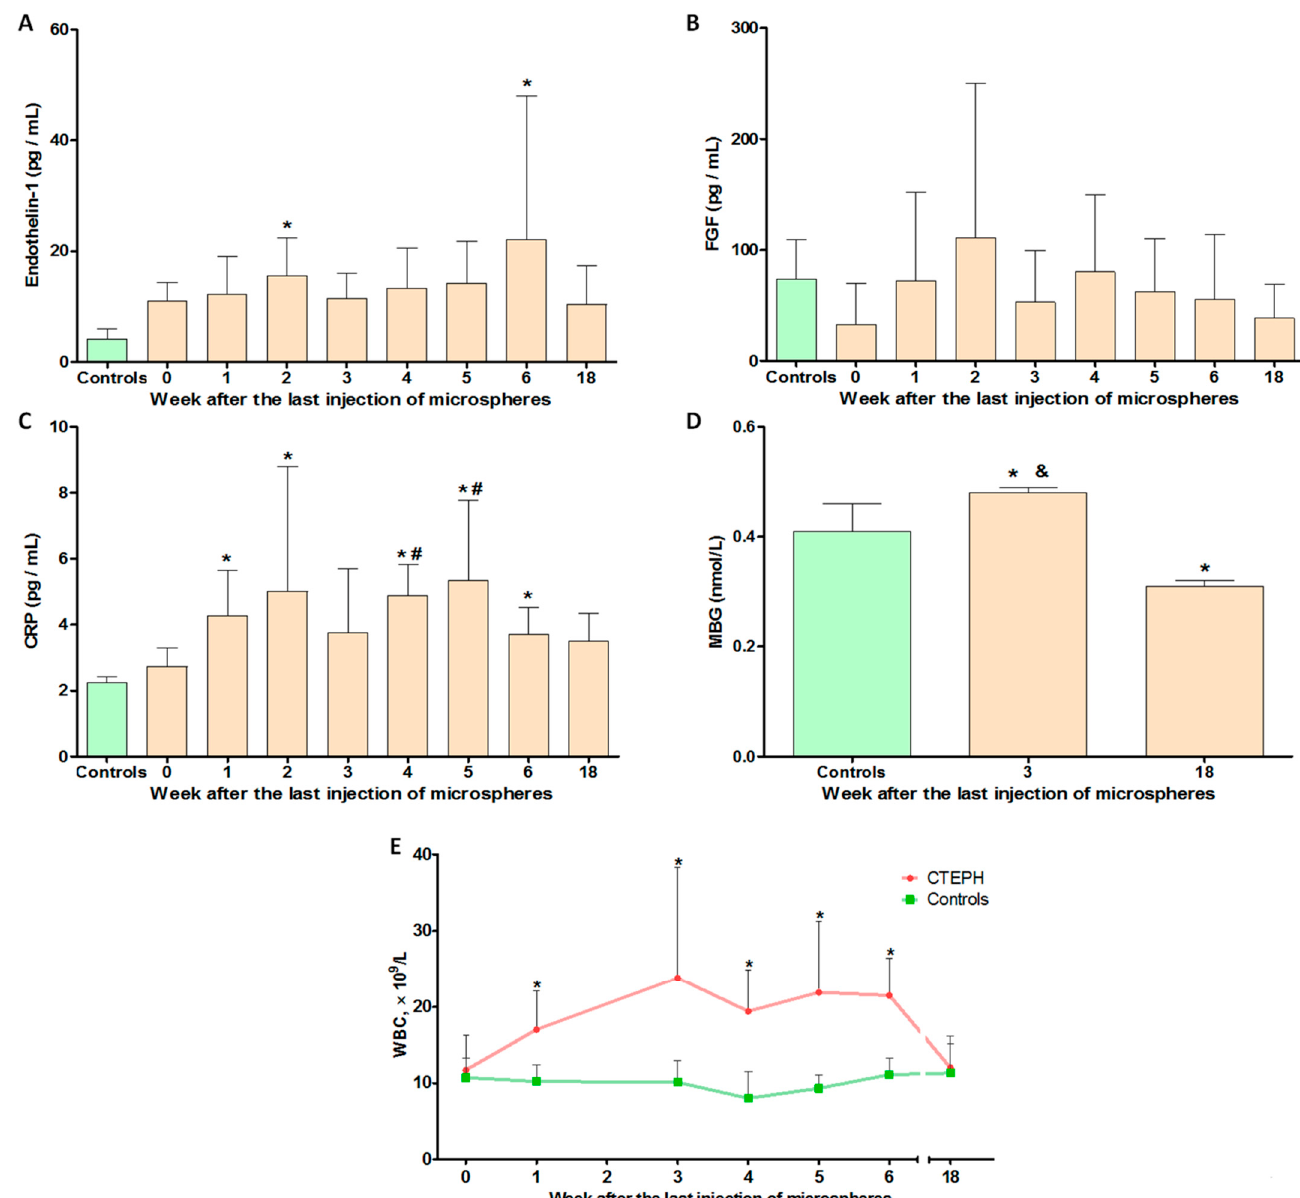
Figure 6. Hematological and biochemical parameters. ( A – D ) Study of paracrine factor content in blood plasma by ELISA. ( A ) The concentration of endothelin-1. ( B ) The concentration of fibroblast growth factor-1 (FGF-1). ( C ) The concentration of C-reactive protein (CRP). ( D ) The concentration of marinobufagenin (MBG). ( E ) The level of leukocytes in the blood. * p < 0.05 in comparison with the control group. # p < 0.05 in comparison with the 0-week subgroup. & p < 0.05 in comparison with the 18-week subgroup. n = 7 at each time point in CTEPH group.